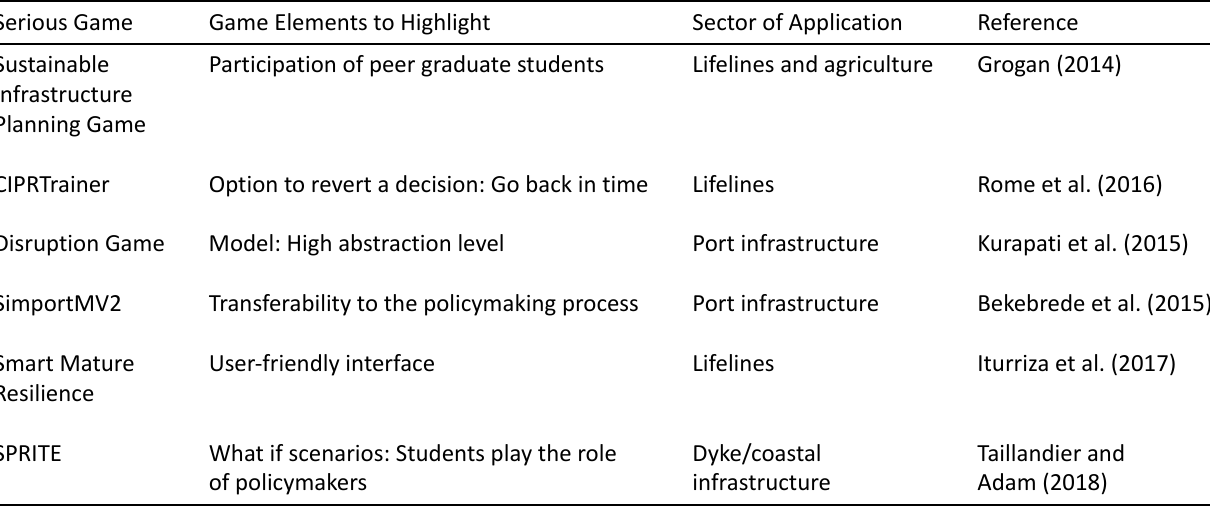
Table 1. Highlights to inform game design from serious games used for community resilience building in civil systems